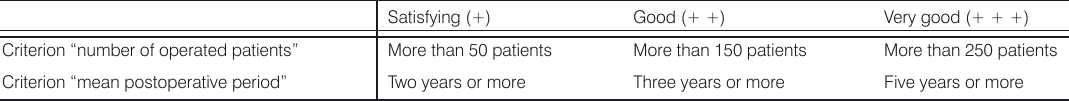
Table 1. Criteria for the comparison of different follow-ups.